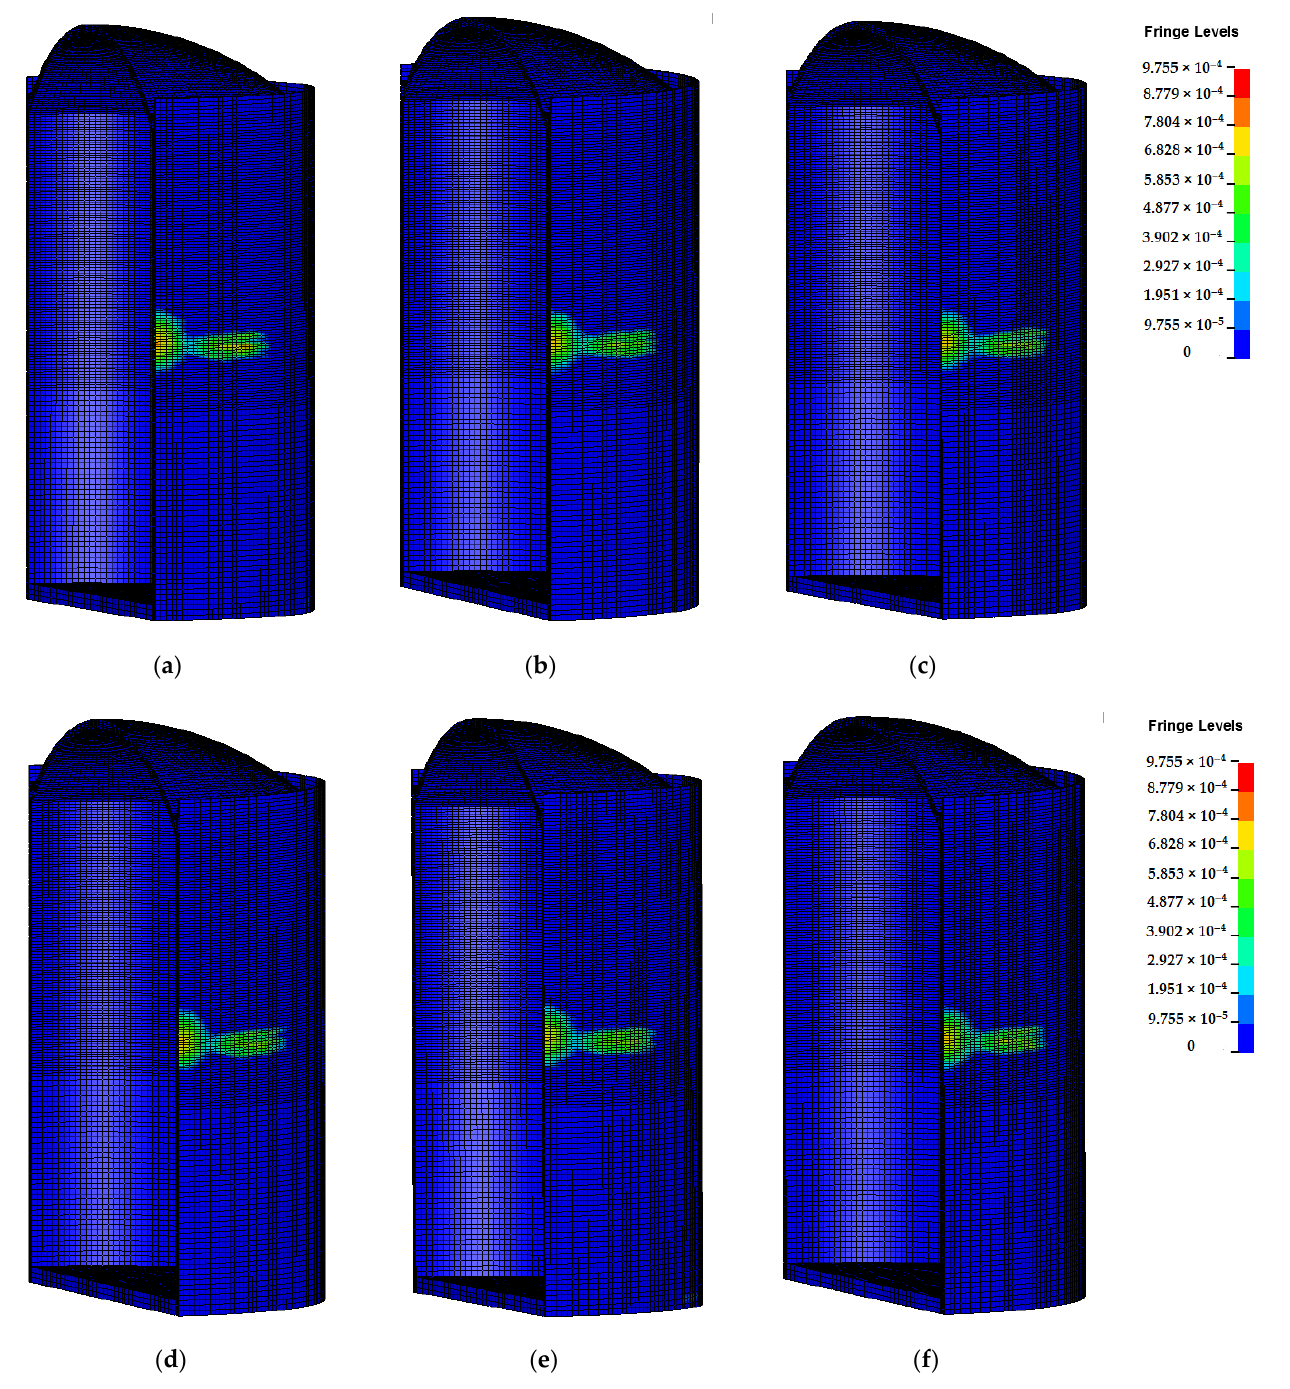
Figure 11. Contours of the maximum plastic strain of concrete of full SC containment for different site conditions. ( a ) Vs = 1000 m/s. ( b ) Vs = 1500 m/s. ( c ) Vs = 2000 m/s. ( d ) Vs = 2500 m/s. ( e ) Vs = 3000 m/s. ( f ) FIXED.